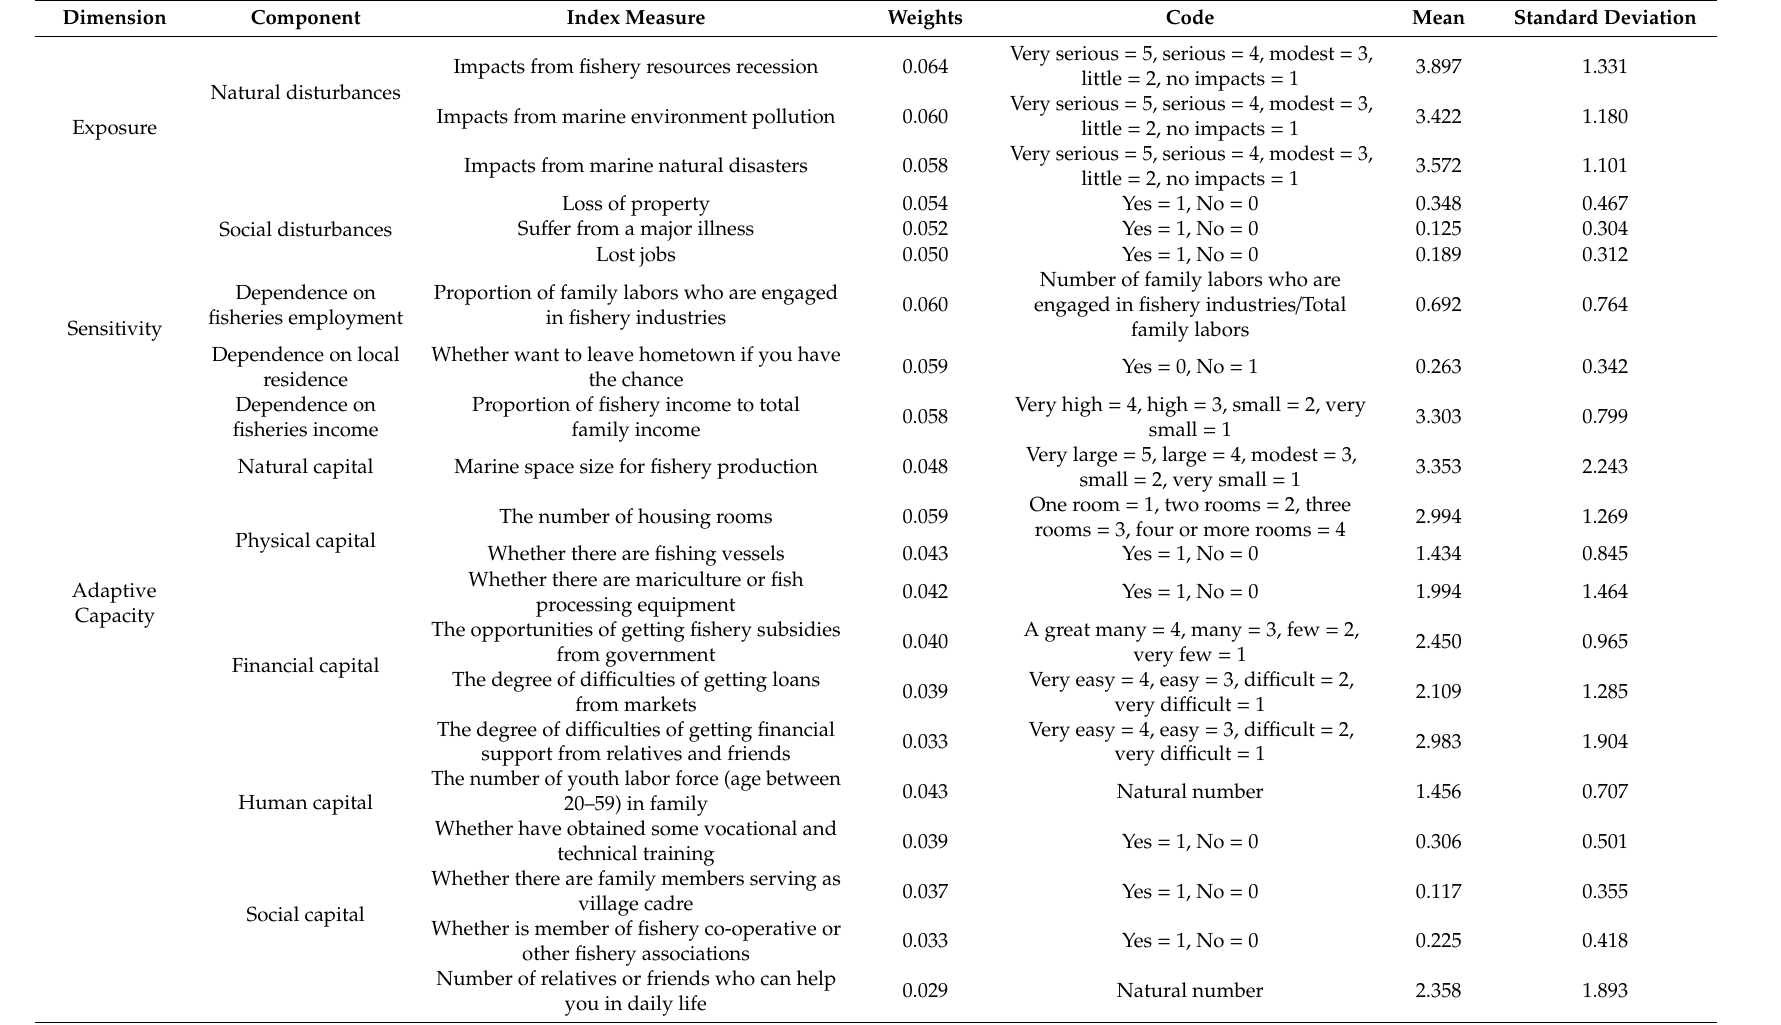
Table 1. Livelihood vulnerability dimension, component, and index description, and code, mean, and standard deviation of indicators.